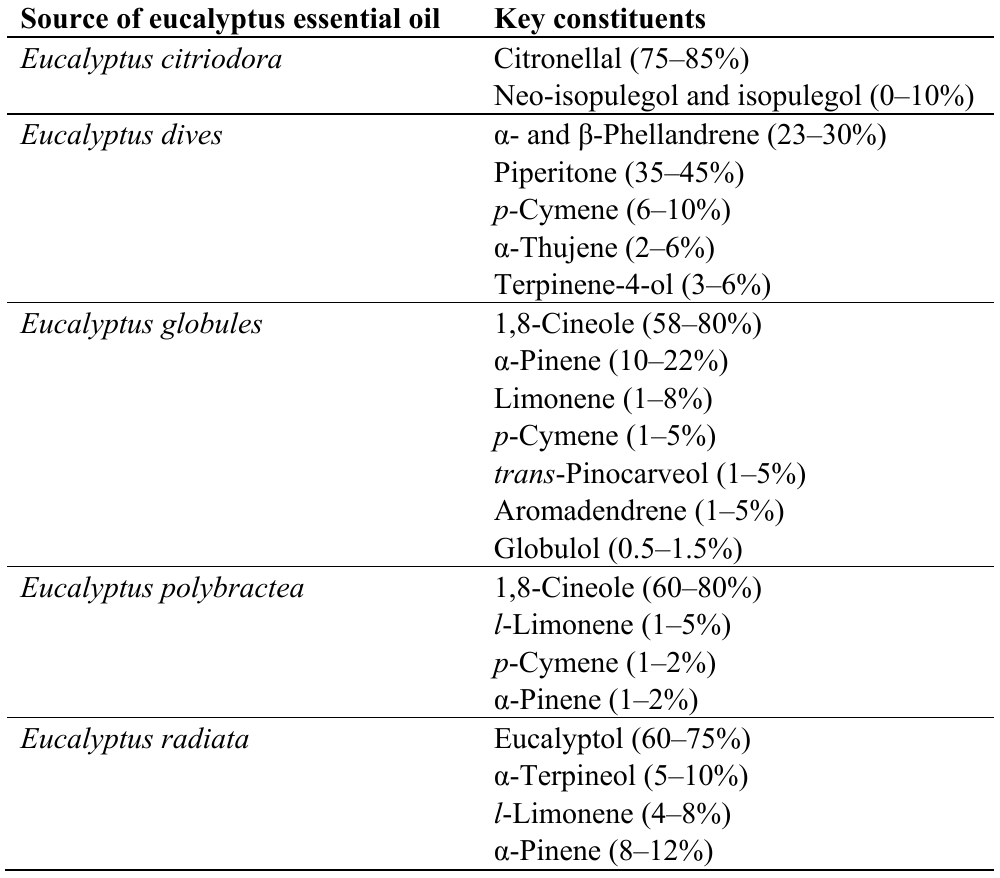
Table 2. Key constituents of Eucalyptus essential oils from different natural sources